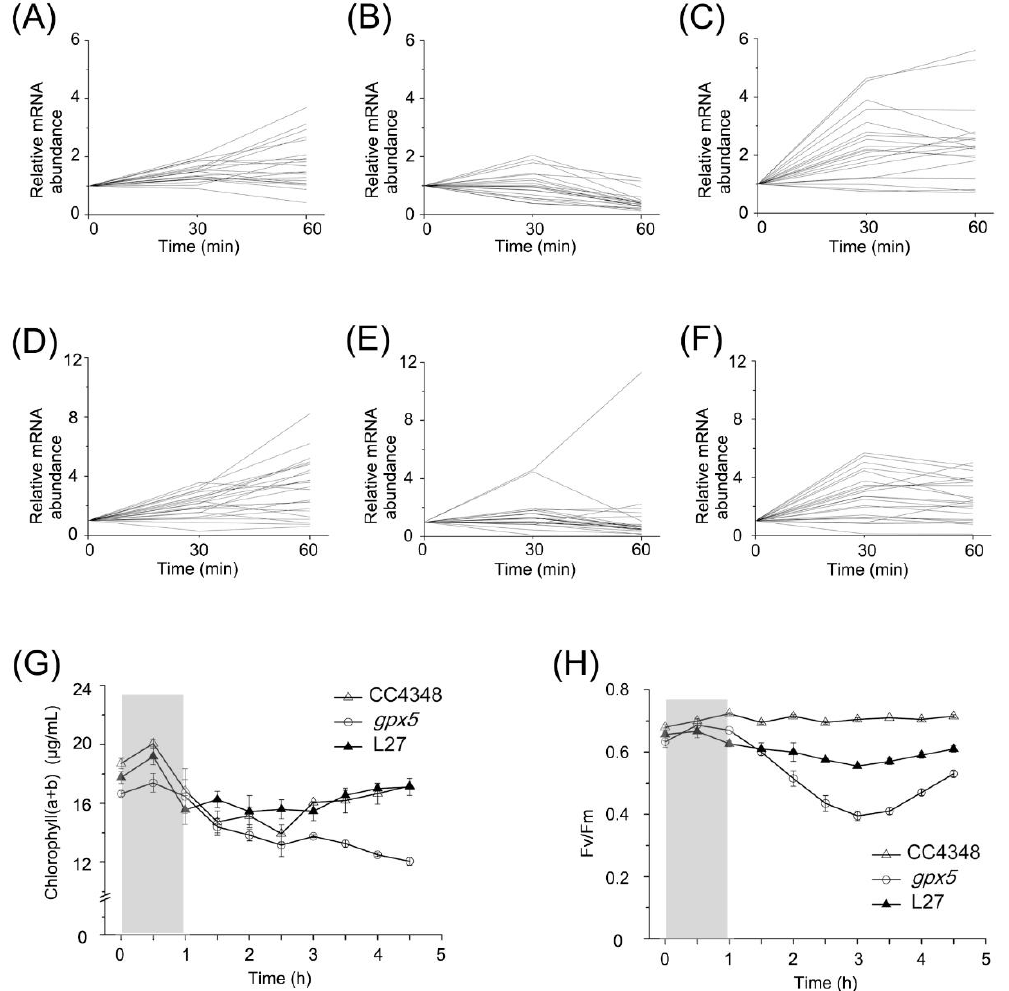
Figure 6. The response of photosystem to 1 O 2 . ( A – C ) The expression pattern of DEGs encoding light-harvesting proteins in CC4348 ( A ), the gpx5 mutant ( B ), and L27 ( C ) after treated with 1 μM RB determined by RNA-seq. ( D – F ) The expression pattern of DEGs related to chlorophyll metabolism in CC4348 ( D ), the gpx5 mutant ( E ), and L27 ( F ) after treated with 1 μM RB determined by RNA-seq. The initial RPKM was set as 1 for each strain, separately, to normalize the data. Genes and corresponding RPKM values used in this analysis can be found in Table S6. ( G , H ) Comparison of the content of chlorophyll ( a + b ) ( G ) and maximum efficiency (Fv/Fm) of photosystem II ( H ) in CC4348, the gpx5 mutant and L27. The same amounts of cells were treated with 1 μM RB for 1 h, and the RB was then washed out, and measurements were taken over a period of 3.5 h. The stage of treatment is shaded with light gray.